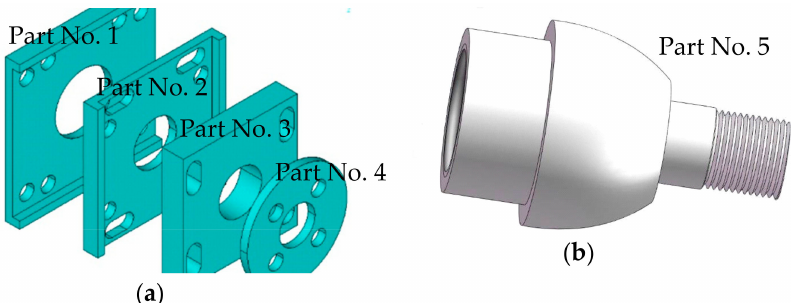
Figure 15. Schematic diagram of the novel apparatus: ( a ) basic parts of the apparatus; ( b ) core part of the apparatus.